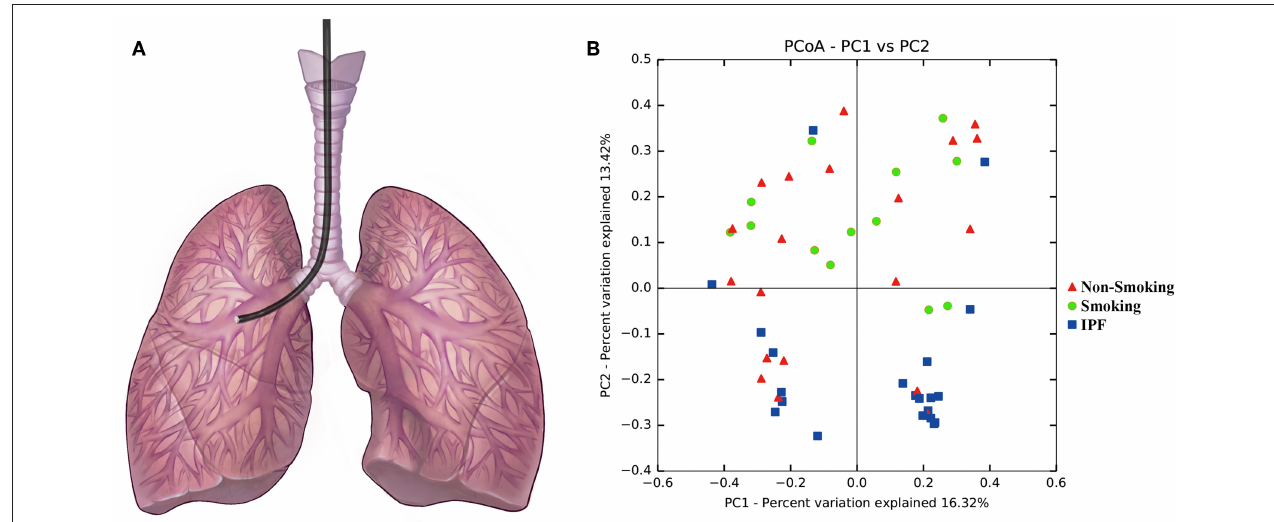
FIGURE 1 | Principal component analysis with BALF samples from IPF patients and health subjects. (A) Diagram of the bronchoscopy performance. (B) Principal component analysis with BALF samples from IPF patients and health subjects (including smokers and non-smokers) was performed based on the taxonomic profiles at species level. Different colors of points were represented for different groups: the blue points represent BALF samples from IPF group, the green points represent BALF samples from smoking control subjects, and the red points represent BALF samples from non-smoking control subjects. BALF samples from IPF patients were with an apparent clustering pattern of microbial composition compared with smoking control subjects, but no significant distribution pattern with the non-smoking control